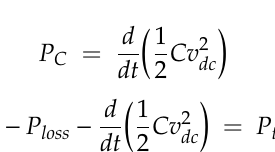
Figure 6. Algorithm Diagram of InCond (Incremental Conductance) Method for Maximum Power Point Tracking.